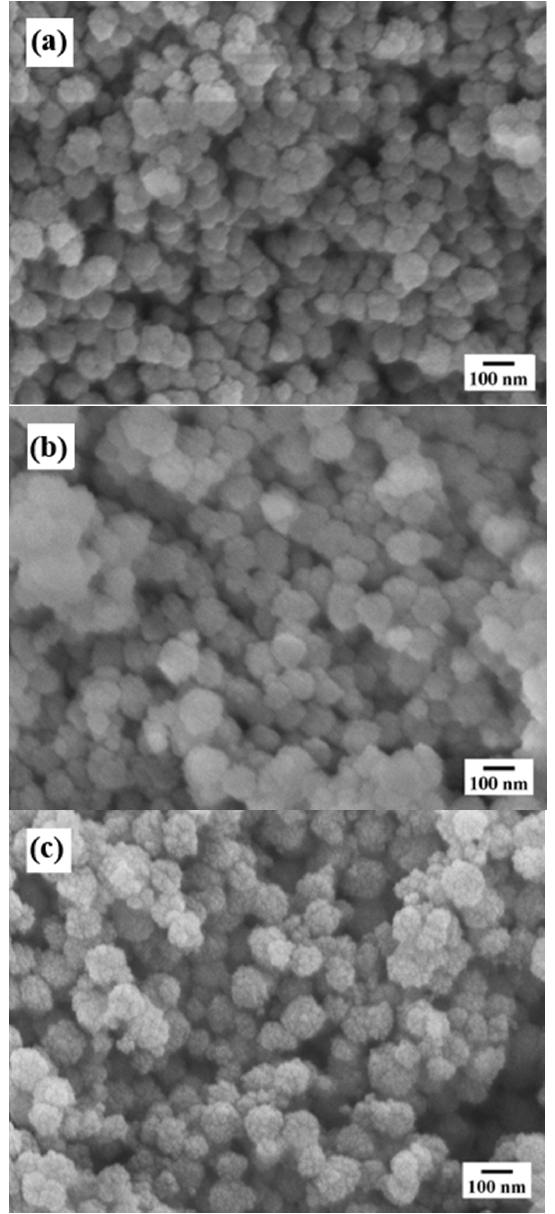
Figure 5. FE-SEM micrographs of Ca 3 Cr 2 Si 3 O 7 powders produced under hydrothermal conditions at 220 °C for 24 h using a 5.0 M KOH solution (12.5 mL) and 3.0 mole Si 4+ precursor mixed content; the experiments were conducted at a stirring speed ( a ) 50 rpm and ( b ) 0 rpm. ( c ) Micrograph of the powders prepared at 240 °C without autoclave stirring under the same experimental conditions.